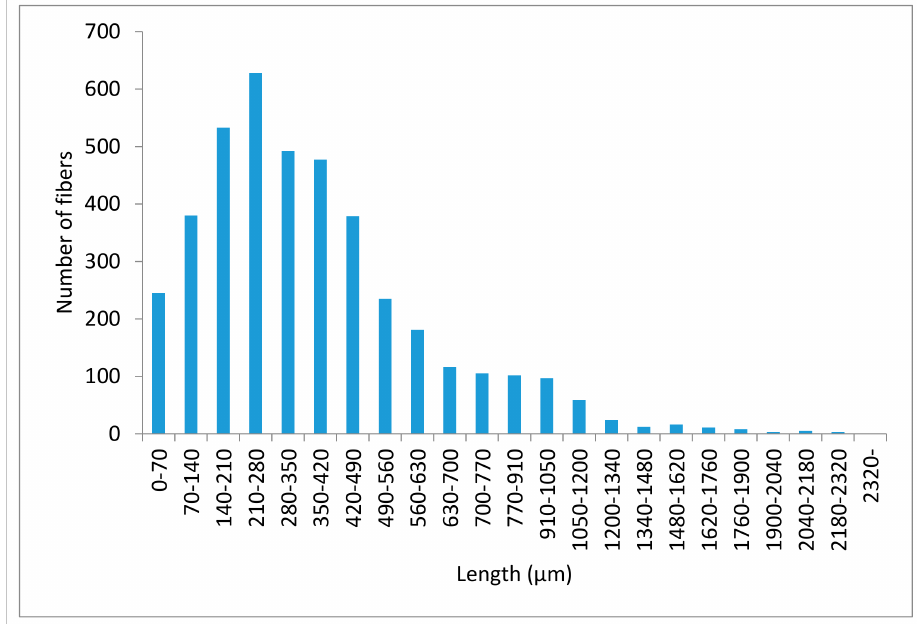
Figure 5. Fiber length distribution of the ONPF extracted from a 30% w / w